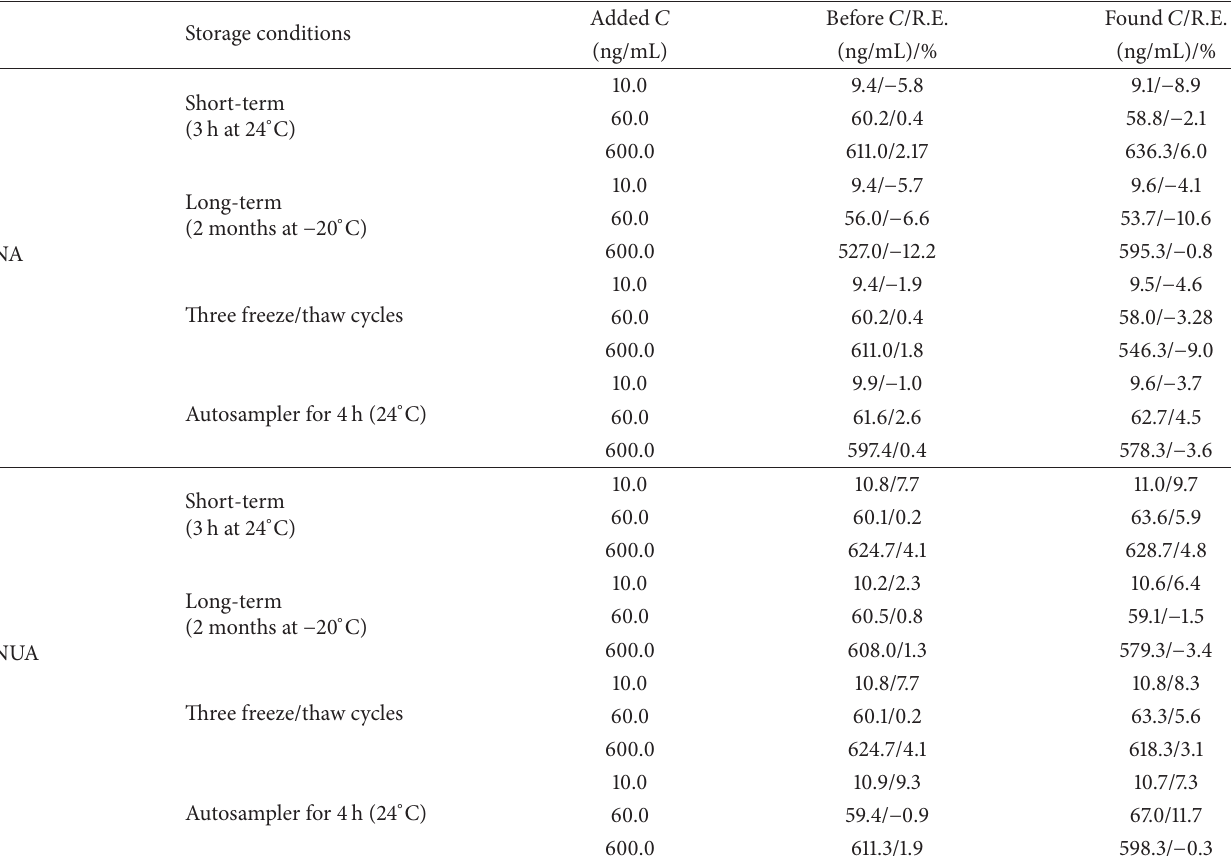
Table 3: Stability data for NA and NUA in human plasma under different storage conditions (before and after analysis, 𝑛 = 3 ). Storage conditions